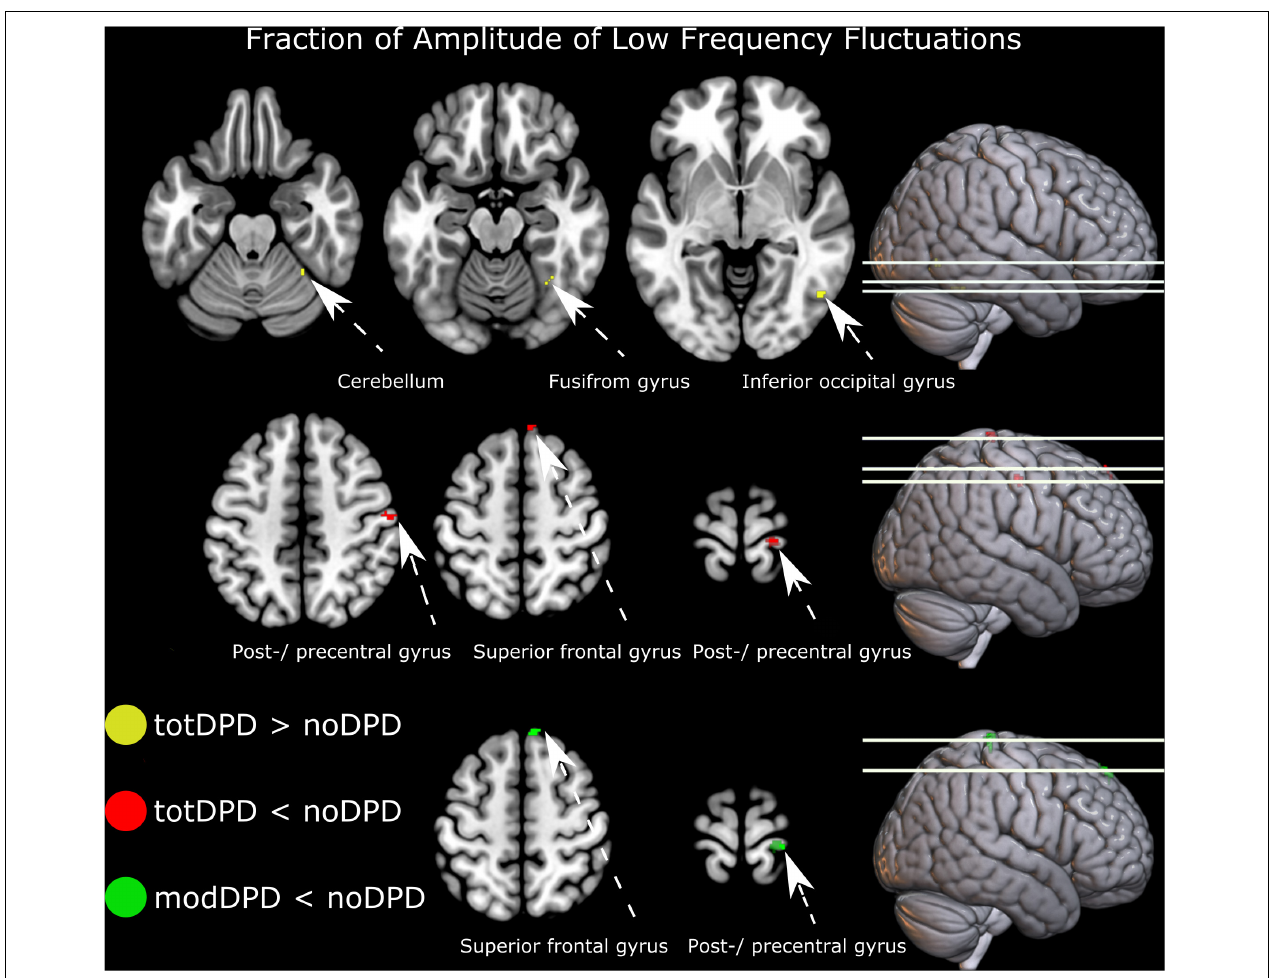
FIGURE 2 | Resting-state alterations in participants with PD and dysarthria (DPD). From top to bottom: group comparison intensity of spontaneous brain activity (fraction of amplitude of low frequency fluctuations) in noDPD vs. totDPD and modDPD vs. noDPD. Results are corrected for multiple comparisons with FWEc p < 0.05. Left is displayed left. Abbreviations: mildDPD, PD with mild dysarthria; modDPD, PD with moderate dysarthria; noDPD, PD with no dysarthria; totDPD, PD with mild and moderate